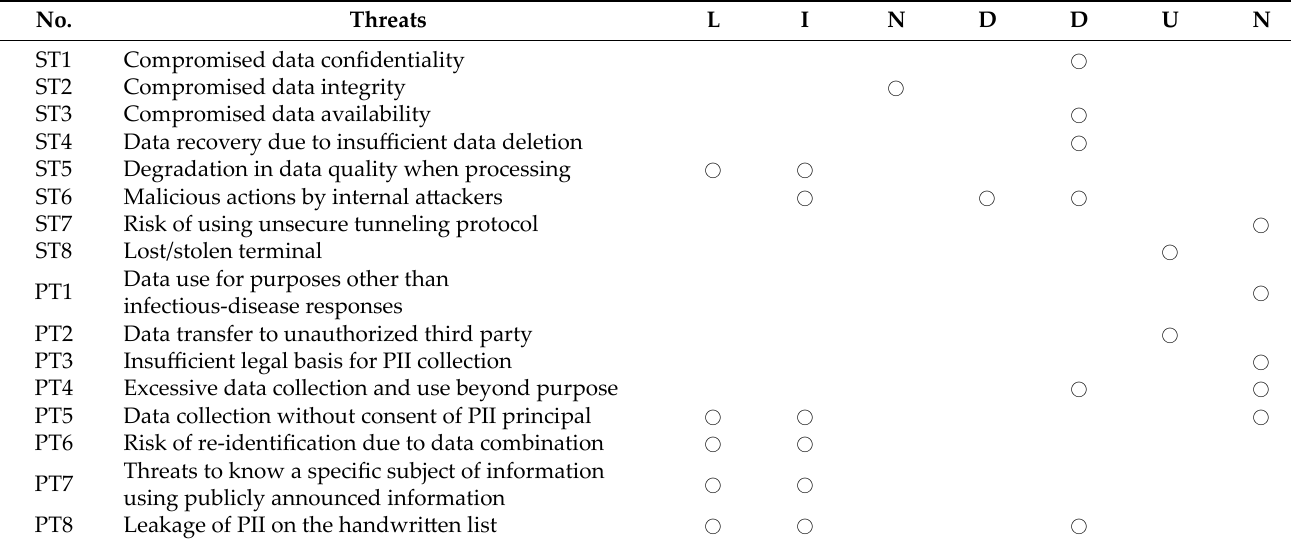
Table 5. Security–privacy threats and LINDDUN mapping lists.